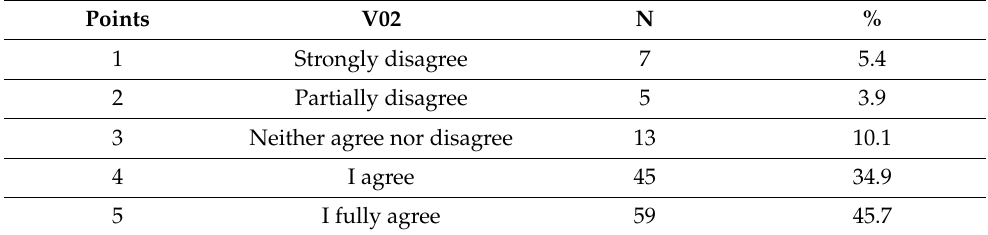
Table 10. Game programming including accessibility. playability and manipulations.